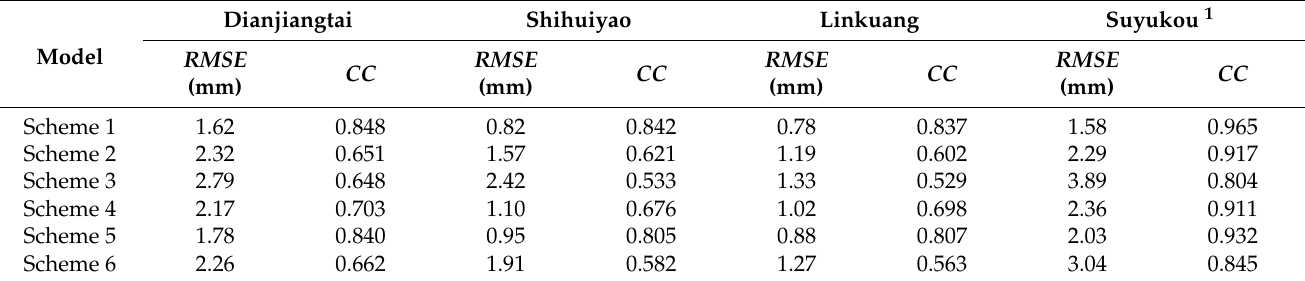
Table 4. Root-mean-square error ( RMSE ) and correlation coefficient ( CC ) of different schemes.